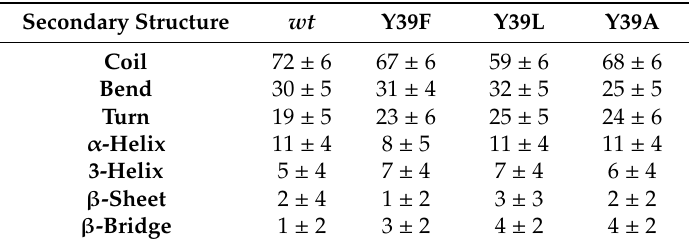
Figure 4. Predicted versus experimental chemical shifts of wt α S. Scatterplots showing the comparison between experimental chemical shifts of C, C, C β , and N atoms and those calculated from our replica exchange with solute tempering (REST2) simulations using the SHIFTX2 code (see Methods for details). Table 1. Number of residues forming di ff erent secondary structure elements, as predicted by our REST2 simulation. The averages values and the corresponding standard deviations are